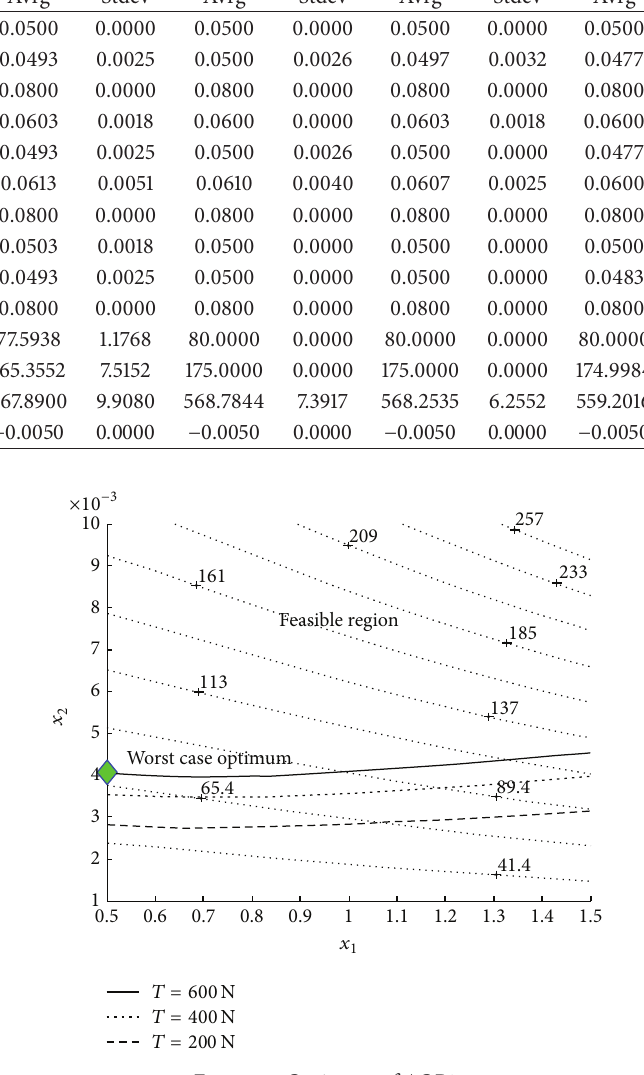
Figure 5: Optimum of